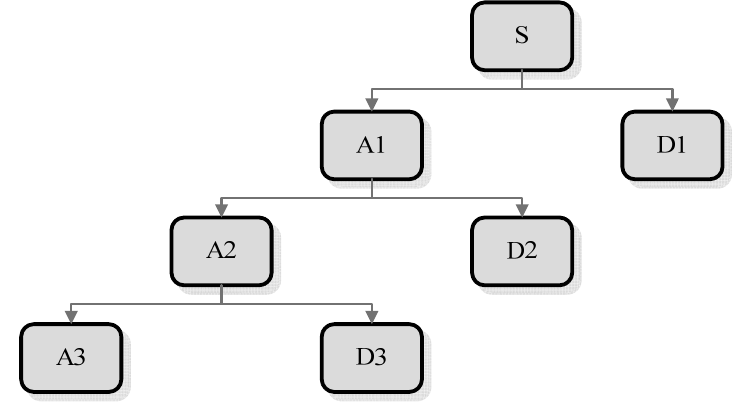
Figure 9. The tree structure of a three layers wavelet decomposition based on multi-resolution